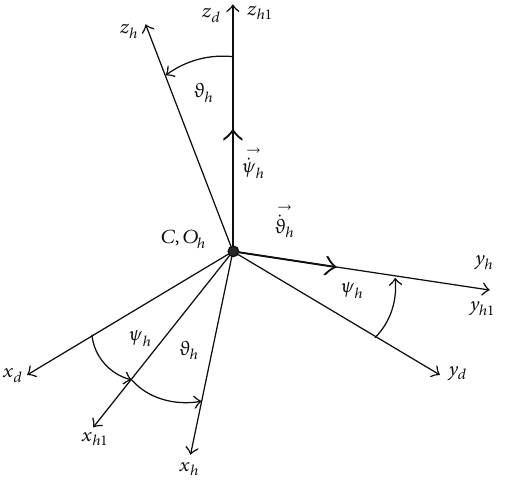
Figure 5: Transformations of the coordinate systems.